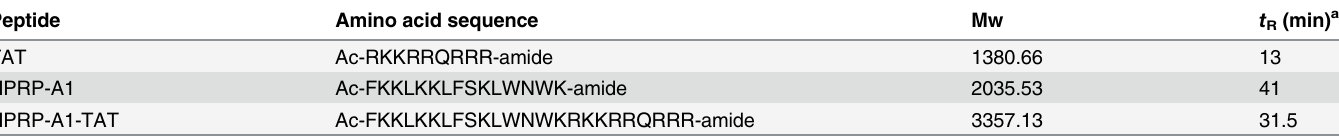
Table 1. Sequences and biophysical data of peptides used in the study.